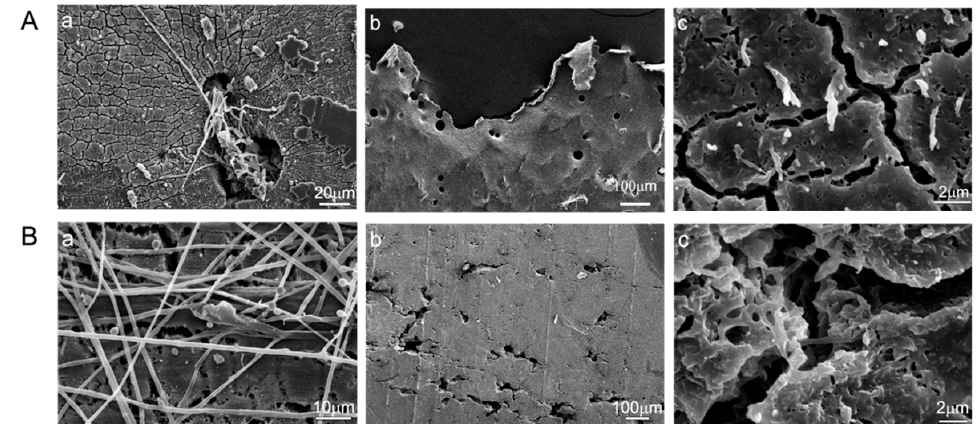
Figure 4. Scanning electron microscopic images of plastic films degraded by two elite fungal strains. PBSA films degraded by A. terreus fumigatus L30 ( A ) and HC ( B ) after 30 days of incubation. ( Aa ) The attachment and network of A. terreus L30 hyphae on the surface of PBSA film, ( Ab ) cracks and holes on the plastic surface, ( Ac ) irregular cavity in internal of plastic film. ( Ba ) A. fumigatus HC hyphae the plastic surface, and ( Bc ) internal erosion of the plastic